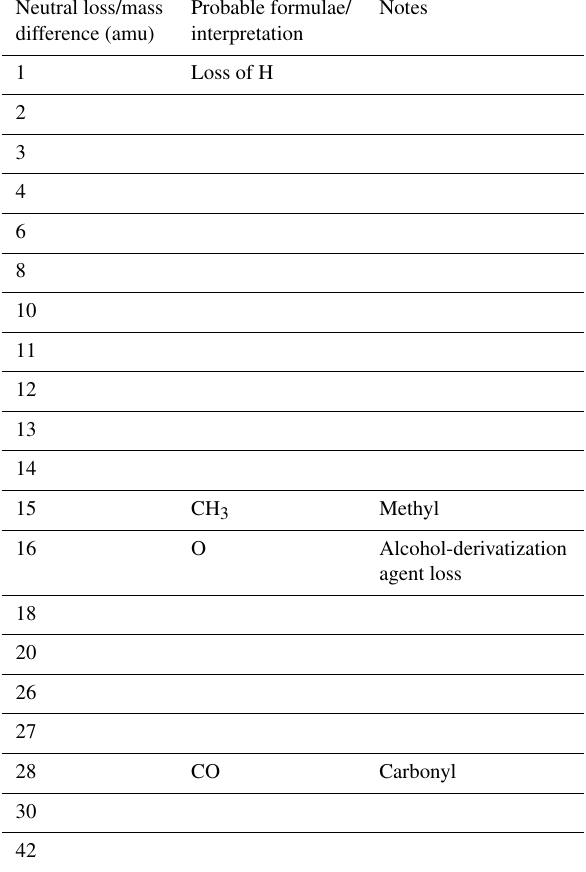
Table A3. The 20 most common neutral mass differences between charged peaks, selected for mass spectral featurization, with possi- ble formulae and implications of commonly reported neutral